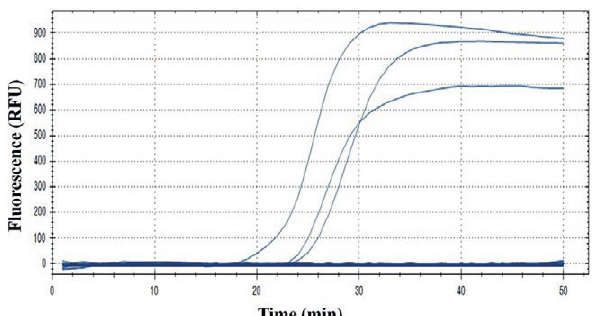
Figure 2. The specificity of the Pleurostoma richardsiae RealAmp method. The amplification plots (RFU) of three representative iso- lates of Pl. richardsiae and other fungus strains. Negative samples showed linear curves.